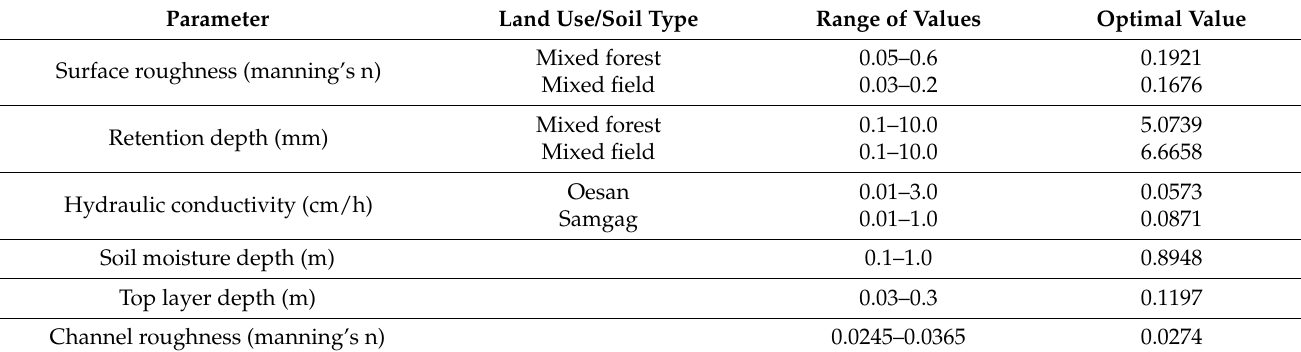
Table 4. Calibrated parameters used in the GSSHA model for flow discharge